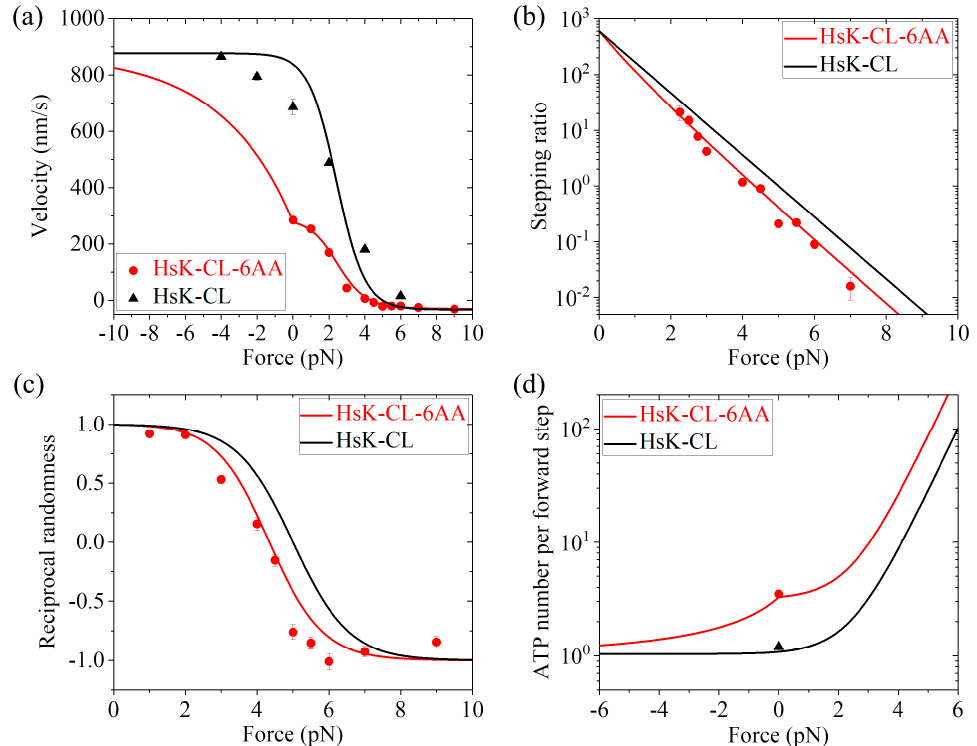
Figure 6. Dynamics of HsK-CL and HsK-CL-6AA at saturating ATP. ( a ) Velocity versus external force. Lines represent analytical solutions. Circles are experimental data for HsK-CL-6AA at 2 mM ATP taken from Clancy et al. [26] (adapted by permission from Springer Nature: Clancy, B.E.; Behnke-Parks, W.M.; Andreasson, J.O.L.; Rosenfeld, S.S.; Block, S.M. A universal pathway for kinesin stepping. Nat. Struct. Mol. Biol. 2011 , 18 , 1020–1027. Licence number: 4680780256064), while triangles are experimental data for HsK-CL at 2 mM ATP taken from Andreasson et al. [24]. ( b ) Stepping ratio versus external force. Lines represent analytical solutions. Symbols are experimental data for HsK-CL-6AA at 2 mM ATP taken from Clancy et al. [26] Adapted by permission from Springer Nature: Clancy, B.E.; Behnke-Parks, W.M.; Andreasson, J.O.L.; Rosenfeld, S.S.; Block, S.M. A universal pathway for kinesin stepping. Nat. Struct. Mol. Biol. 2011 , 18 , 1020–1027. Licence number: 4680780256064. ( c ) Reciprocal randomness versus external force. Lines represent analytical solutions. Symbols are experimental data for HsK-CL-6AA at 2 mM ATP taken from Clancy et al. [26]. Adapted by permission from Springer Nature: Clancy, B.E.; Behnke-Parks, W.M.; Andreasson, J.O.L.; Rosenfeld, S.S.; Block, S.M. A universal pathway for kinesin stepping. Nat. Struct. Mol. Biol. 2011 , 18 , 1020–1027. Licence number: 4680780256064. ( d ) Number of ATP molecules consumed per forward step versus external force. Lines represent analytical solutions. Circle is the experimental data for HsK-CL-6AA at 2 mM ATP taken from Clancy et al. [26] (adapted by permission from Springer Nature: Clancy, B.E.; Behnke-Parks, W.M.; Andreasson, J.O.L.; Rosenfeld, S.S.; Block, S.M. A universal pathway for kinesin stepping. Nat. Struct. Mol. Biol. 2011 , 18 , 1020–1027. Licence number: 4680780256064), while triangle is the experimental data for HsK-CL at 1 mM ATP taken from Yildiz et al.